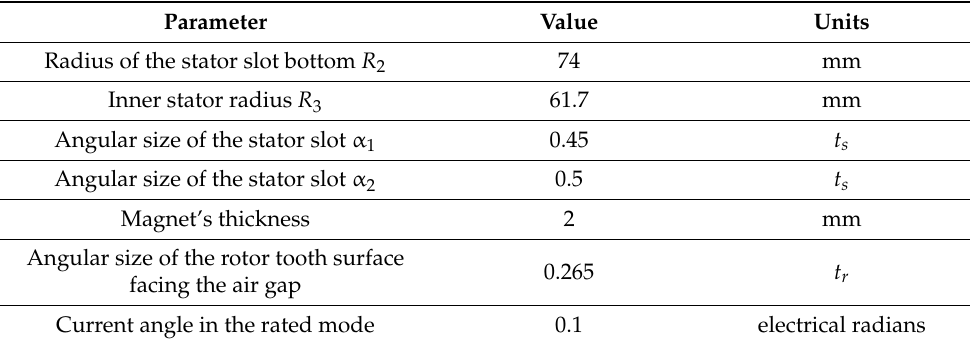
Angular size of the rotor tooth surface facing the air gap Current angle in the rated mode 0.1 electrical